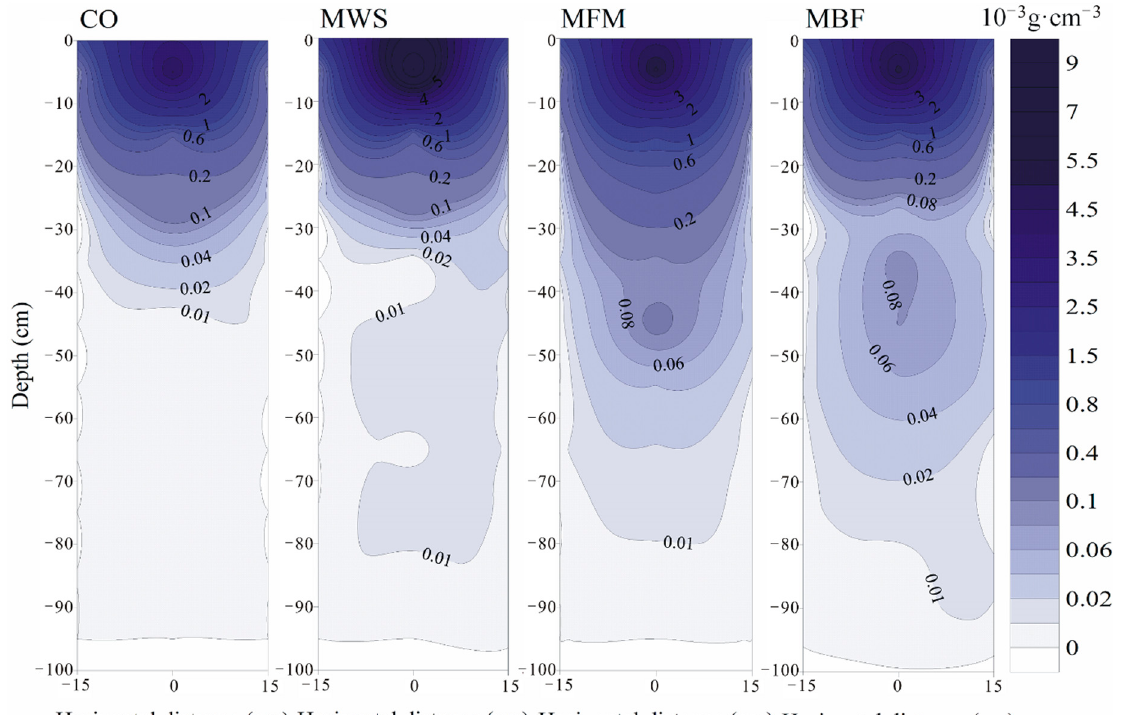
Figure 6. Two-dimensional distributions of the mean root-weight density in the 0–100 cm layer under indicated treatments at maturity averaged over two years. The abbreviations of the treatment names are the same as those described in Figure 2.